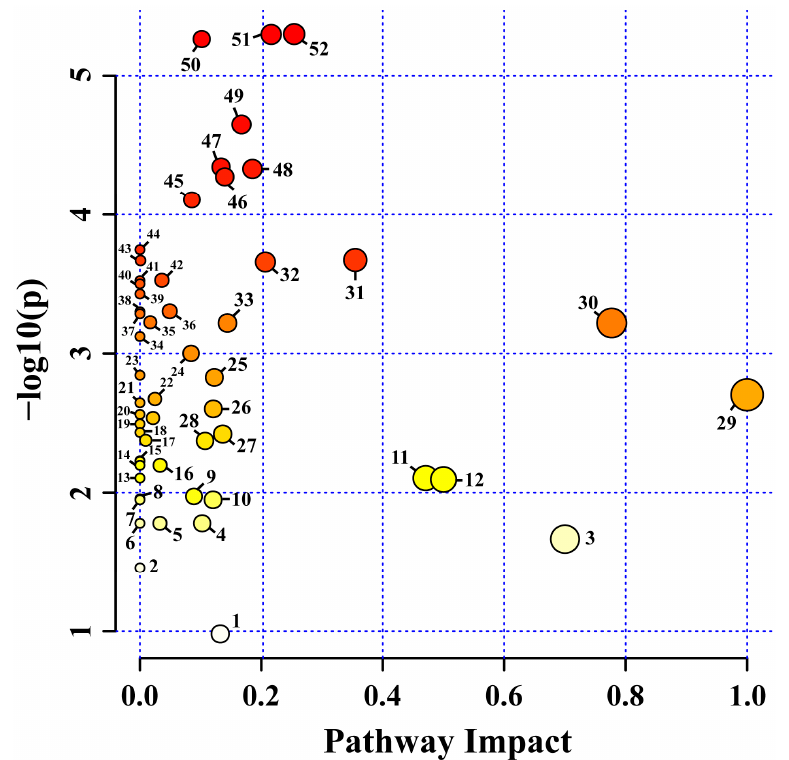
Figure 9. Identi fi ed metabolites and their pathway impact on kohlrabi sprouts after exposure to di ff erent LED light conditions. (1) Stilbenoid, diarylheptanoid and gingerol biosynthesis, (2) Terpe- noid backbone biosynthesis, (3) Flavone and fl avonol biosynthesis, (4) Inositol phosphate metabo- lism, (5) Phosphatidylinositol signaling system, (6) Ascorbate and aldarate metabolism, (7) Indole alkaloid biosynthesis, (8) Valine, leucine and isoleucine degradation, (9) Starch and sucrose metab- olism, (10) Tryptophan metabolism, (11) Phenylalanine metabolism, (12) Isoquinoline alkaloid bio- synthesis, (13) Tropane, piperidine and pyridine alkaloid biosynthesis, (14) Propanoate metabolism, (15) Pentose and glucuronate interconversions, (16) Sulfur metabolism, (17) Glycerophospholipid metabolism, (18) Purine metabolism, (19) Selenocompound metabolism, (20) Nitrogen metabolism, (21) Fa tt y acid degradation, (22) Flavonoid biosynthesis, (23) Nicotinate and nicotinamide metabo- lism, (24) Pantothenate and CoA biosynthesis, (25) Galactose metabolism, (26) Glycolysis/Glucone- ogenesis, (27) Butanoate metabolism, (28) Valine, leucine and isoleucine biosynthesis, (29) Biosyn- thesis of secondary metabolites—unclassi fi ed, (30) Alanine, aspartate and glutamate metabolism, (31) Glycine, serine and threonine metabolism, (32) Glyoxylate and dicarboxylate metabolism, (33) Arginine and proline metabolism, (34) Monobactam biosynthesis, (35) Glycerolipid metabolism, (36) Carotenoid biosynthesis, (37) Pyrimidine metabolism, (38) Thiamine metabolism, (39) Cy- anoamino acid metabolism, (40) Glucosinolate biosynthesis, (41) Aminoacyl-tRNA biosynthesis, (42) Carbon fi xation in photosynthetic organisms, (43) Ubiquinone and other terpenoid-quinone bi- osynthesis, (44) Amino sugar and nucleotide sugar metabolism, (45) Arginine biosynthesis, (46) Cys- teine and methionine metabolism, (47) Glutathione metabolism, (48) Citrate cycle (TCA cycle), (49) Pyruvate metabolism, (50) Phenylpropanoid biosynthesis, (51) Tyrosine metabolism, and (52) Beta- alanine metabolism.